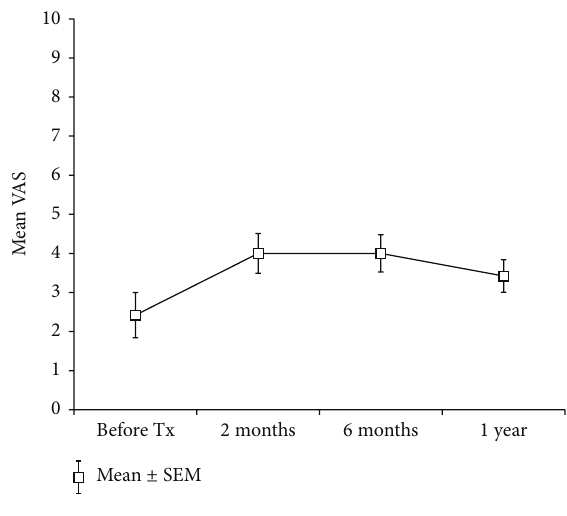
Figure 1: Visual analog scores (VAS).